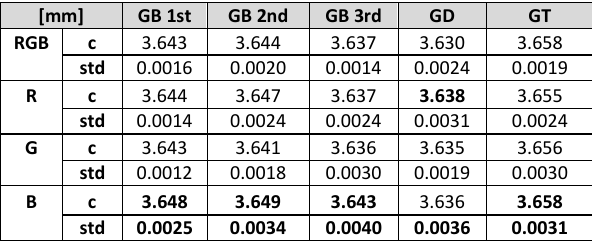
Table 3. Comparison of the principle distance for the individual calibrations of all assessed cameras (1st repeat). All units in mm. The largest values and standard deviations are